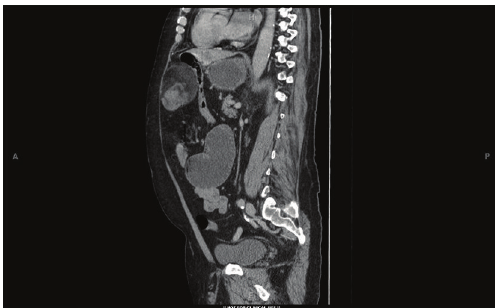
Figure 3: Computed tomographic sagittal image showing anterior epigastric mass compressing distal small bowel, causing dilated duodenum and stomach